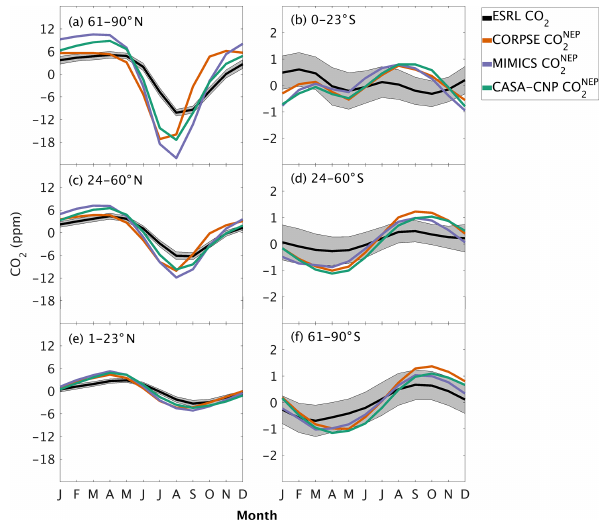
Figure 3. Climatological annual cycle (median) of CO 2 for obser- vations (black) and global net ecosystem productivity flux (CO NEP , 2 colors) between 1982 and 2010. Monthly climatology values were created after detrending the CO 2 time series for atmospheric sam- pling bands in the (a–c) Northern Hemisphere (d–f) and Southern Hemisphere. Note the change in y -axis scale between the two hemi- spheres and the sign of CO NEP reflects the combination of CO NPP 2 2 and CO HR (Eq. 3). Shading on the observed line represents one 2 standard deviation due to interannual variability in the seasonal cy-